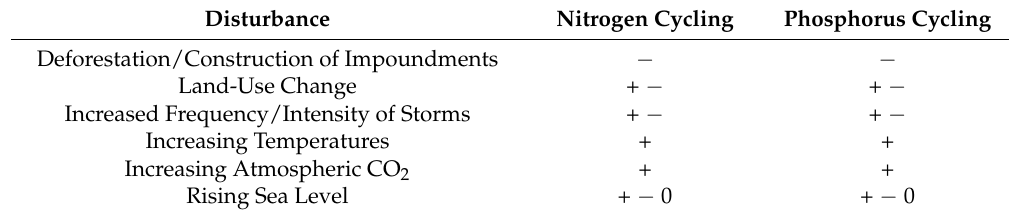
Table 1. Impacts of global change on mangrove nutrient cycling. “+” = stimulatory, “ − ” = deleterious.